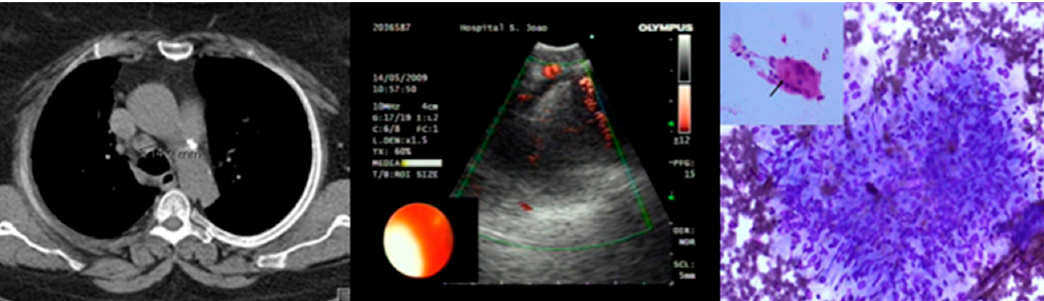
Figure 1. Endobronchial ultrasound in a patient with mediastinal lymph node abnormalities and suspicion of sarcoidosis diagnosis. EBUS ‐ TBNA of an enlarged lymph node (station 4R) with